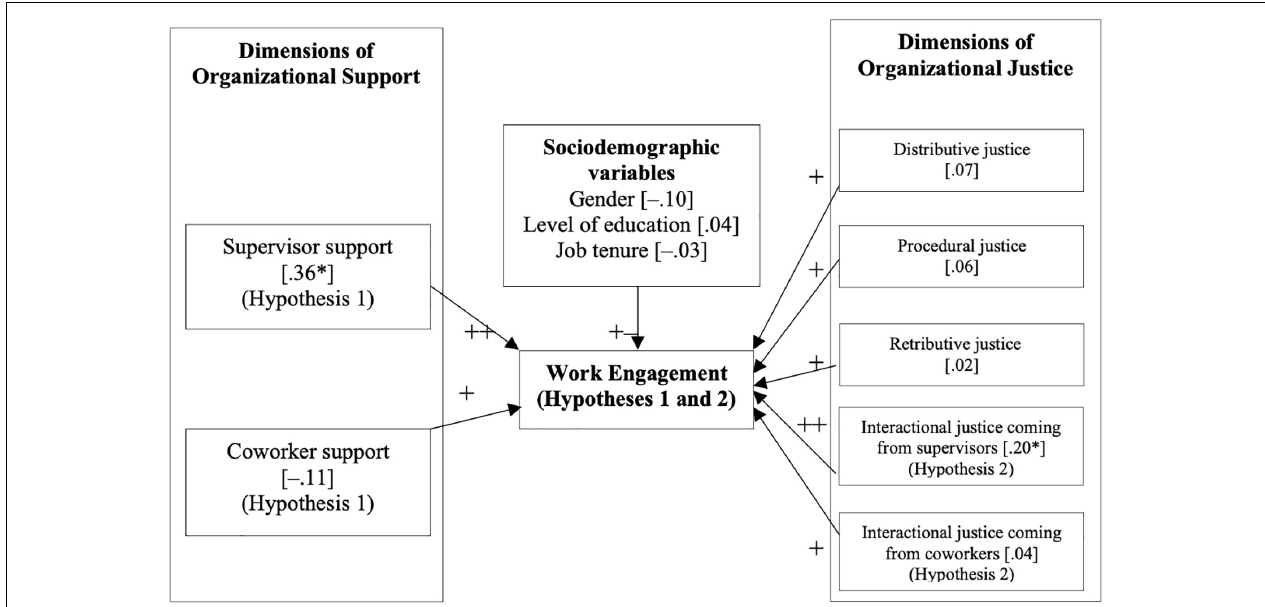
FIGURE 2 | Structural equation model used for WE prediction. Asterisks ∗ denote a strong partial correlation. Pearson correlation coefficients are given in square brackets []. Asterisks ∗ denote and a statistically significant correlation ( p = 0.05).